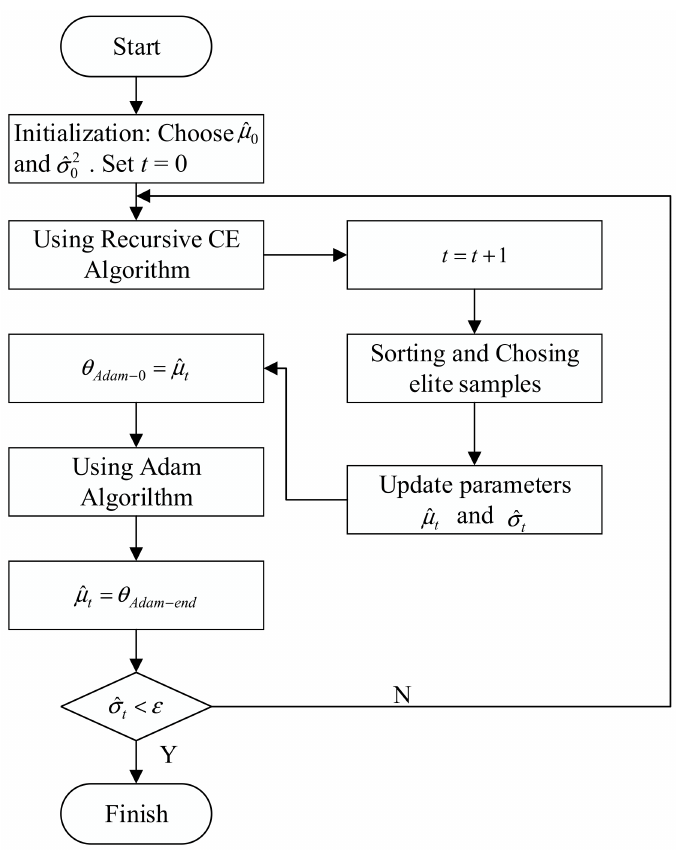
Figure 2. Flow chart of the cross-entropy adaptive moment estimation (CE-Adam) algorithm.